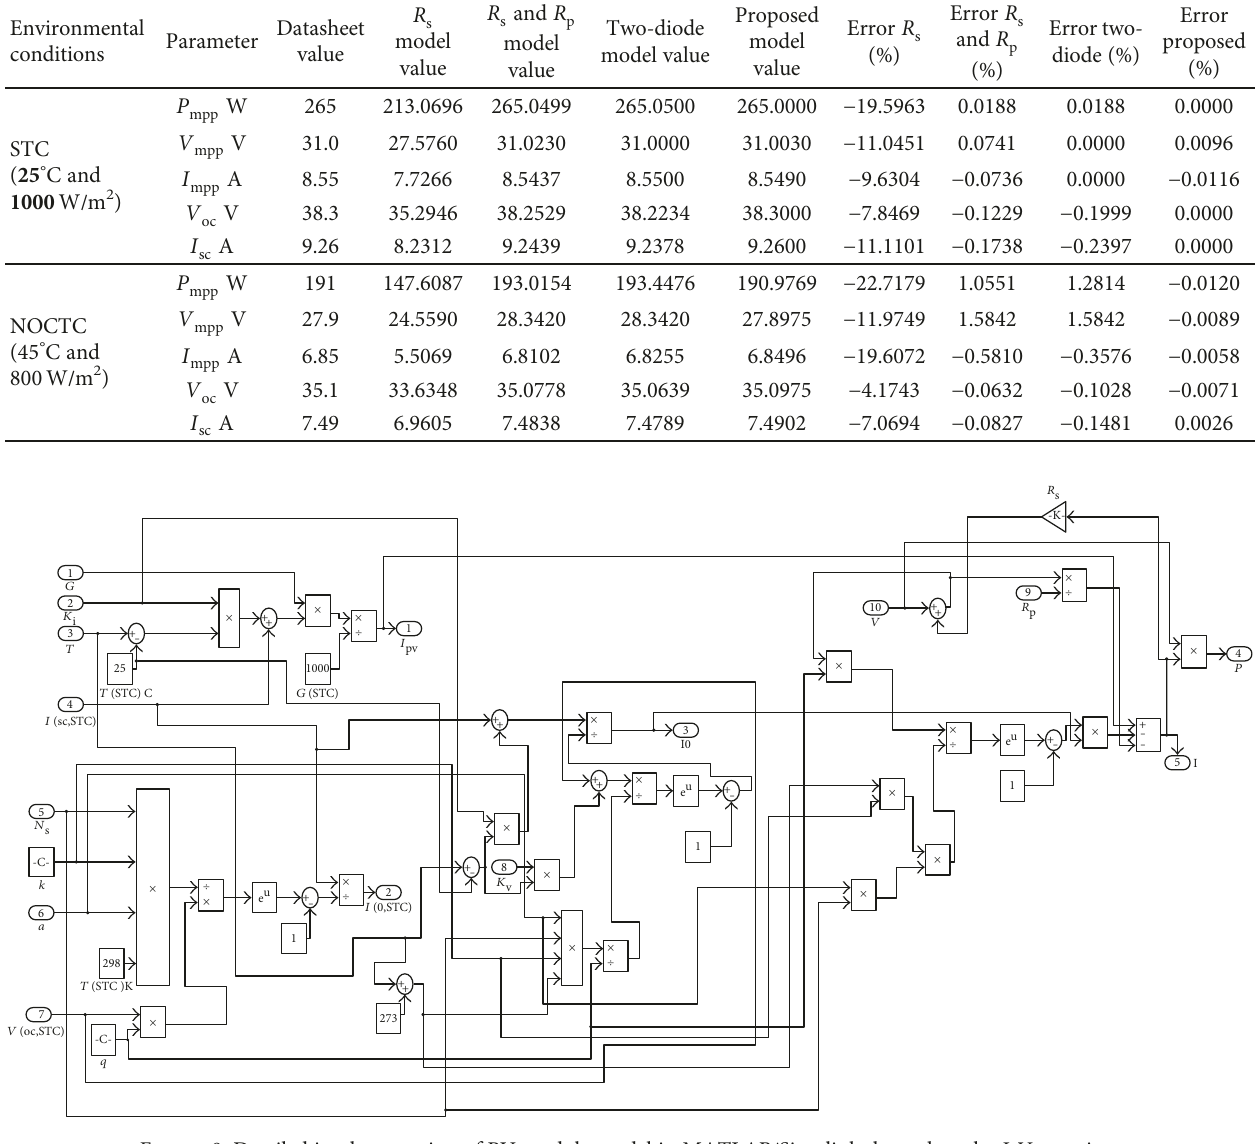
model, R and R model, two-diode model, and proposed model output with manufacturer ’ s datasheet for s s p